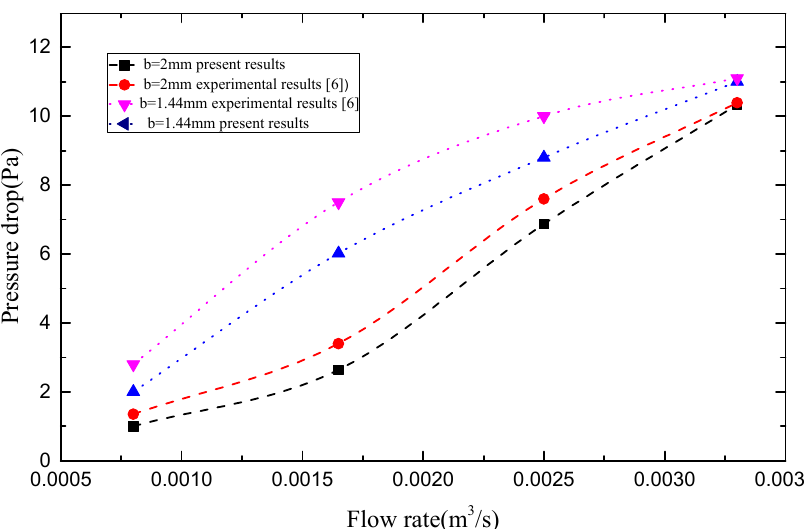
Figure 6. Comparison between the present numerical simulations and the experimental results obtained by Kim et al. [6].